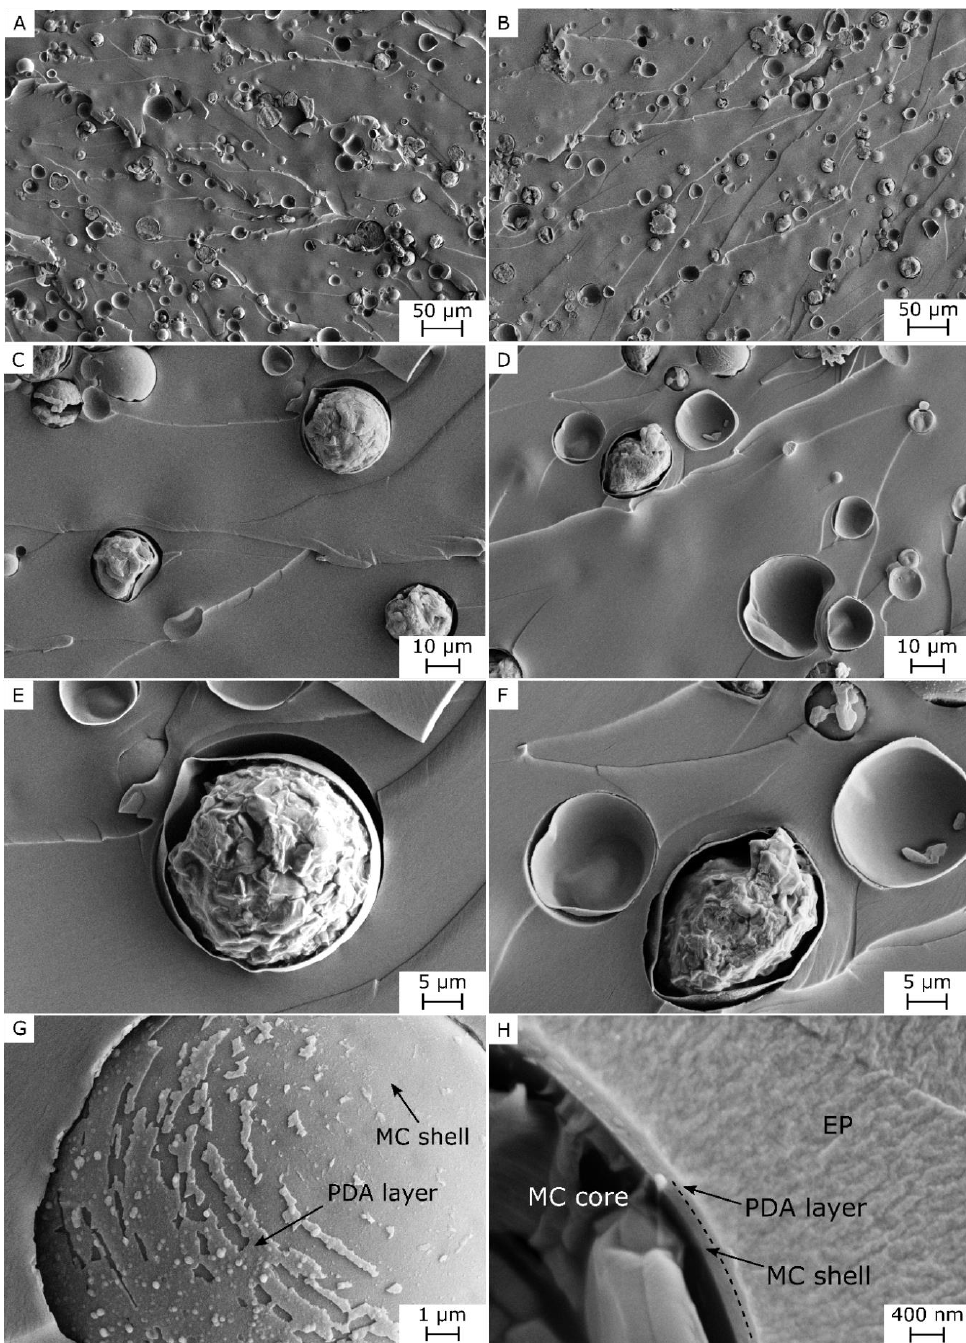
Figure 2. SEM micrographs of tensile-test fracture surface of some selected compositions, at different magnification levels. ( A , C , E ) EP-MC10; ( B , D , F , G , H ) EP-MC10-PDA. magnification levels. ( A , C , E ) EP-MC10; ( B , D , F , G , H )